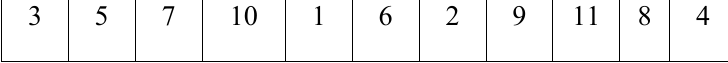
Fig. 1 . SA solution representation